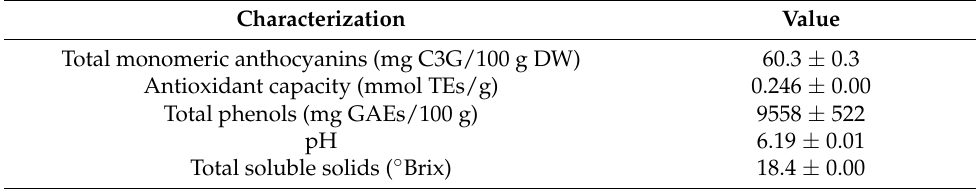
Table 6. Anthocyanin optimized extract